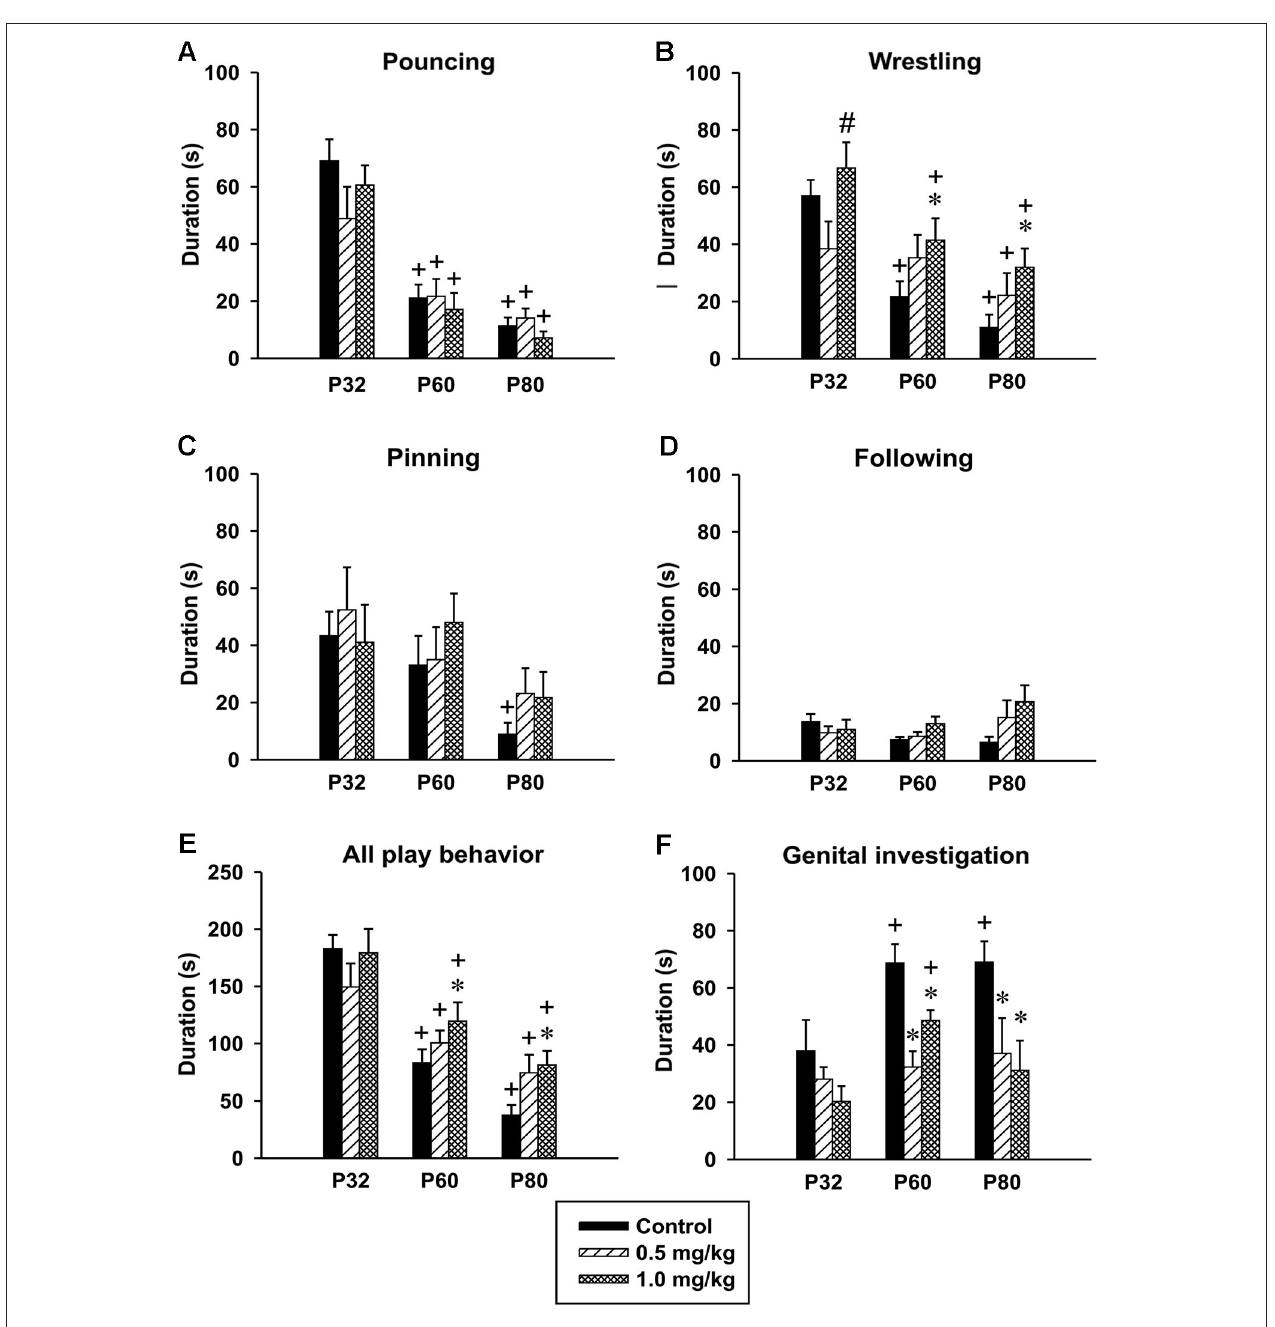
behavior) (E) and total duration of genital investigation (F) . * Significant difference compared to corresponding control groups. + Significant difference compared to P32. # Significant difference compared to 0.5 mg/kg dose of